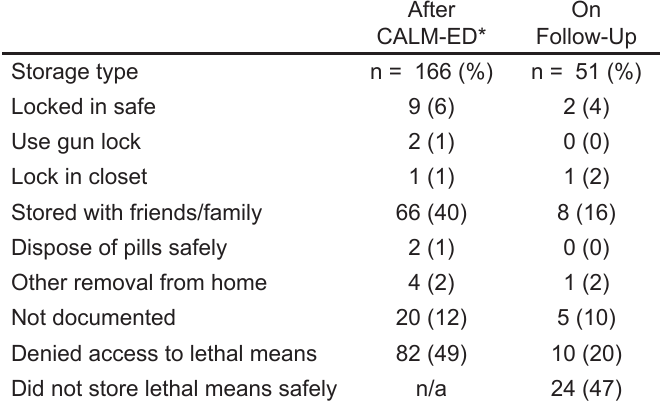
Table 3. Storage plan after CALM-ED and at time of follow-up telephone